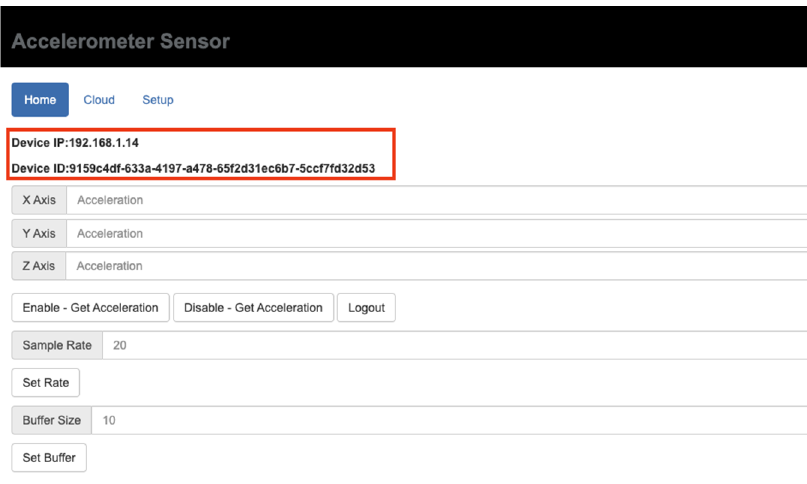
Figure 11. Home tab of sensor device user interface.